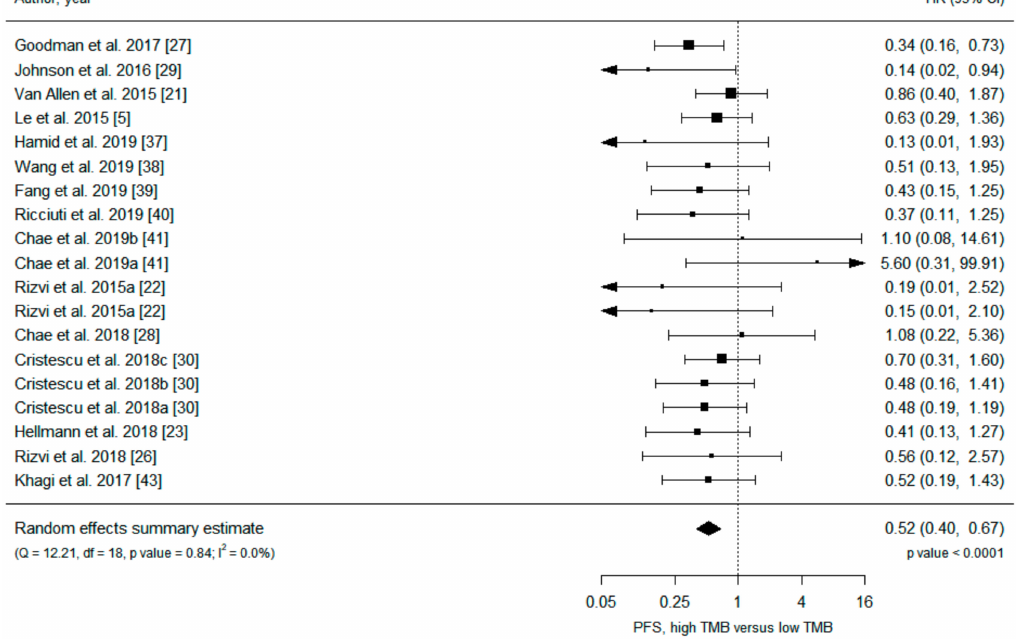
Figure 3. Meta-analysis of immune checkpoint inhibitor therapy and progression-free survival, high TMB group versus low TMB